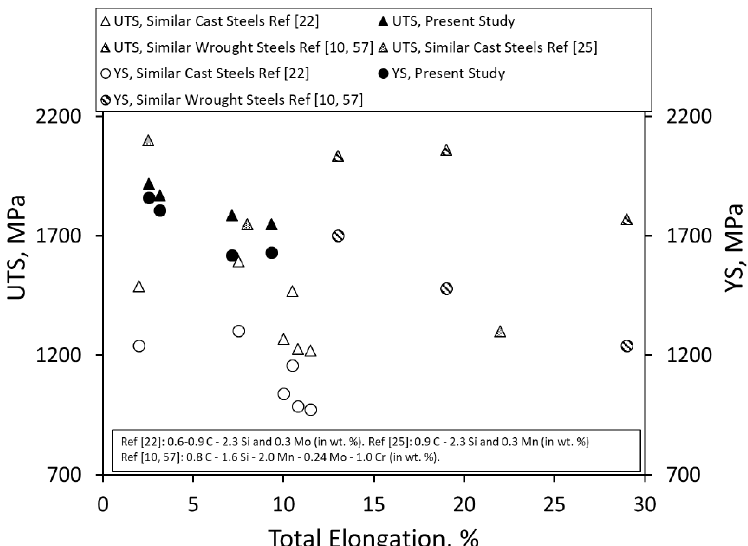
Figure 8. Comparison between tensile properties of similar wrought steels data from [10,57] and cast steels data from [22,25] with those reported in this study.